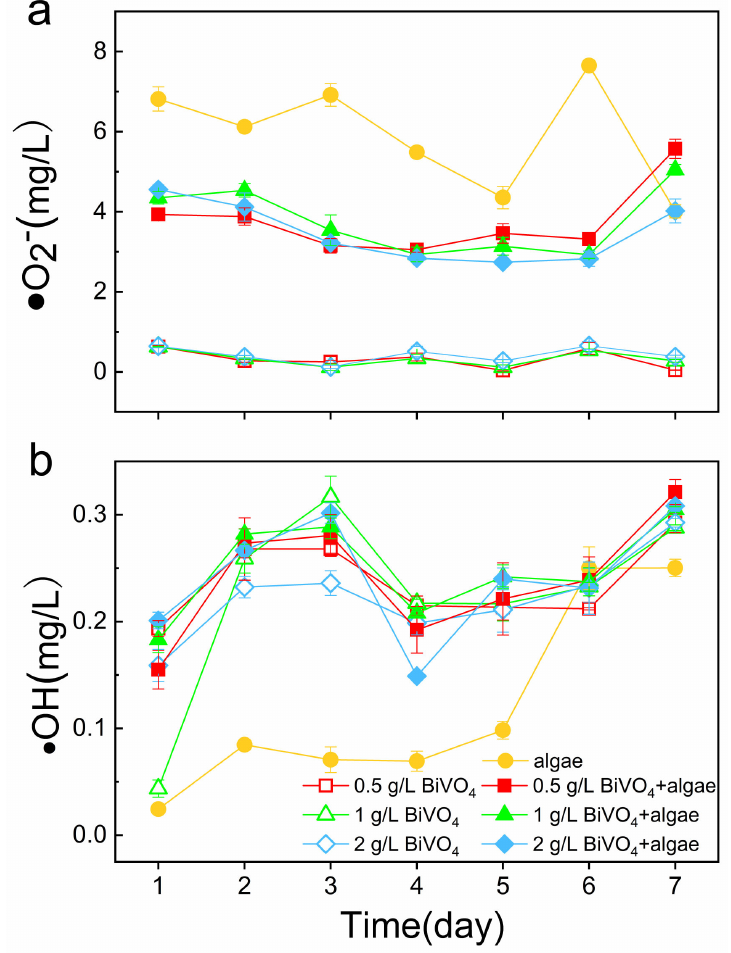
Figure 3. Changes of • O 2 − ( a ) and • OH ( b ) contents in the treatment group (BiVO 4 -algae) and control groups (algae and BiVO 4 ) during the